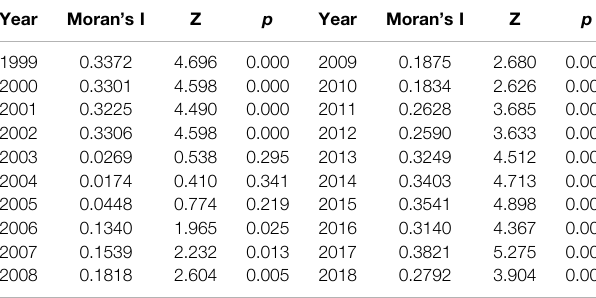
TABLE 2 | The Moran ’ s I of agricultural eco-ef fi ciency from 1999 to